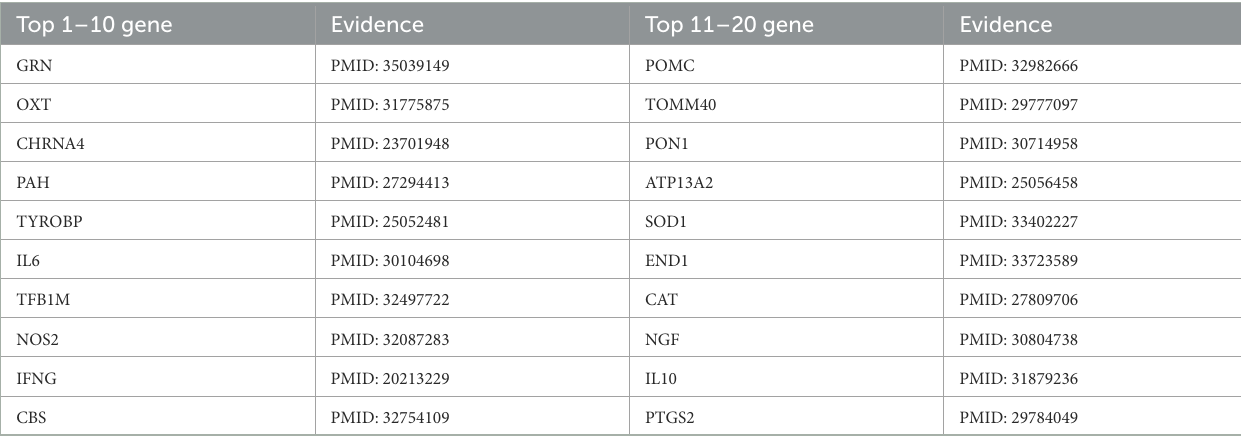
TABLE 4 Top 20 related genes of AD predicted by PSNE.